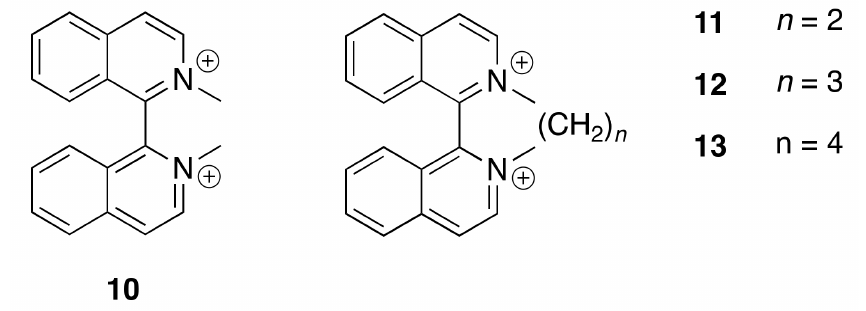
Figure 7. Some 1,1 (cid:48) -biisoquinolinium